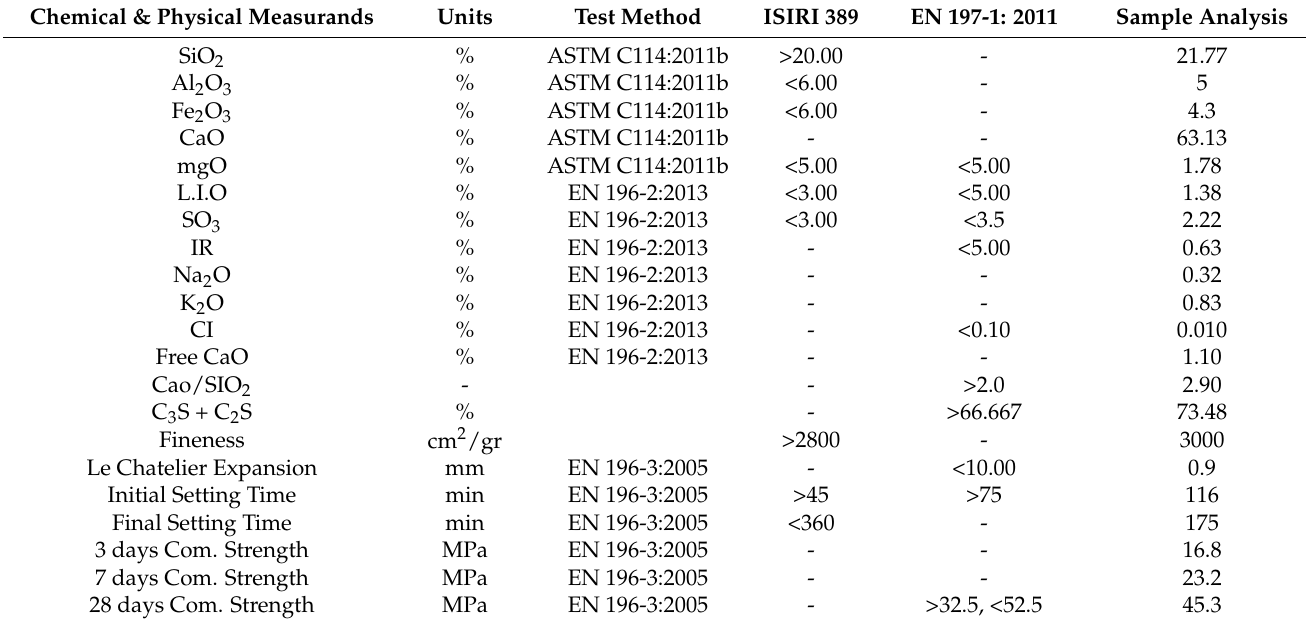
Table 3. Chemical and physical properties of cement.